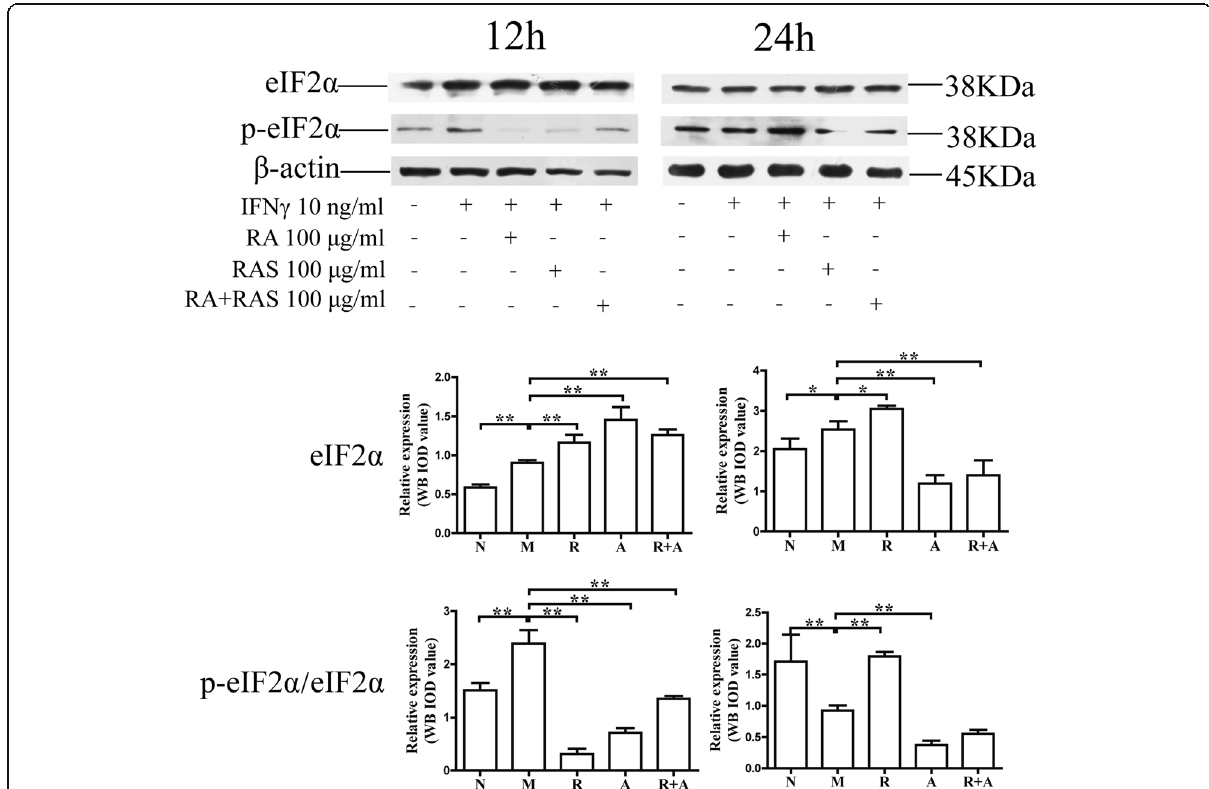
Fig. 9 Interference in the levels of phospho-eIF2 α in BM cells at 100 μ g/mL of Radix Astragali and Radix Angelicae Sinensis treatment. The expression levels of eIF2 α and phospho-eIF2 α in BM cells were determined by Western blot analysis. β -actin was used as an internal control. The quantified results are presented in a bar chart. Data are presented as the mean ± SD, n = 3. * P < 0.05 and ** P <